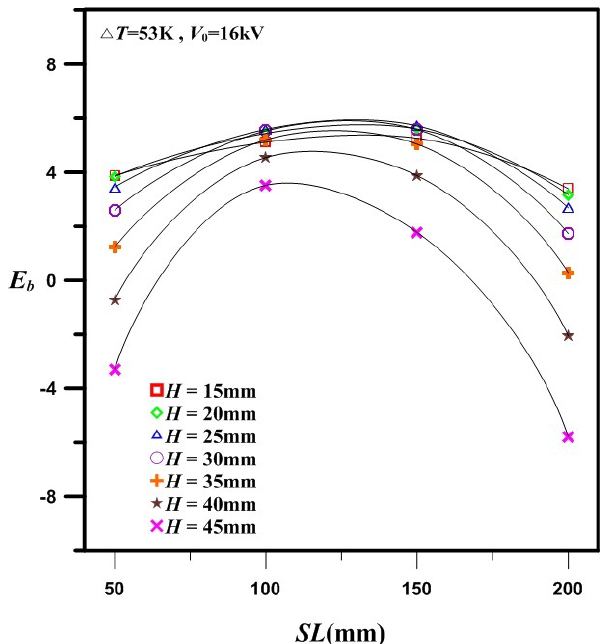
Figure 16. Variations in E b versus electrode pitch for different heights (Δ T = 53 K and V 0 = 16 kV). Figure 17a–c display the iteration process used to search for the optimum electrode height ( H ) and pitch ( SL ) combination for the maximization of objective function (i.e., heat transfer enhancement per power consumption, E b ) at V 0 = 16 kV, with (a) Δ T = 33 K, (b) Δ T = 53 K and (c) Δ T = 73 K, respectively. The contours of the net heat transfer benefit are plotted as a function of H and SL , where the dark red area represents the maximum heat transfer enhancement per power consumption. It can be seen that, by using the simple conjugated gradient method (SCGM), the optimal H and SL combination are obtained ( H = 32.2 mm and SL = 125.8 mm), ( H = 27.5 mm and SL = 128.2 mm), and